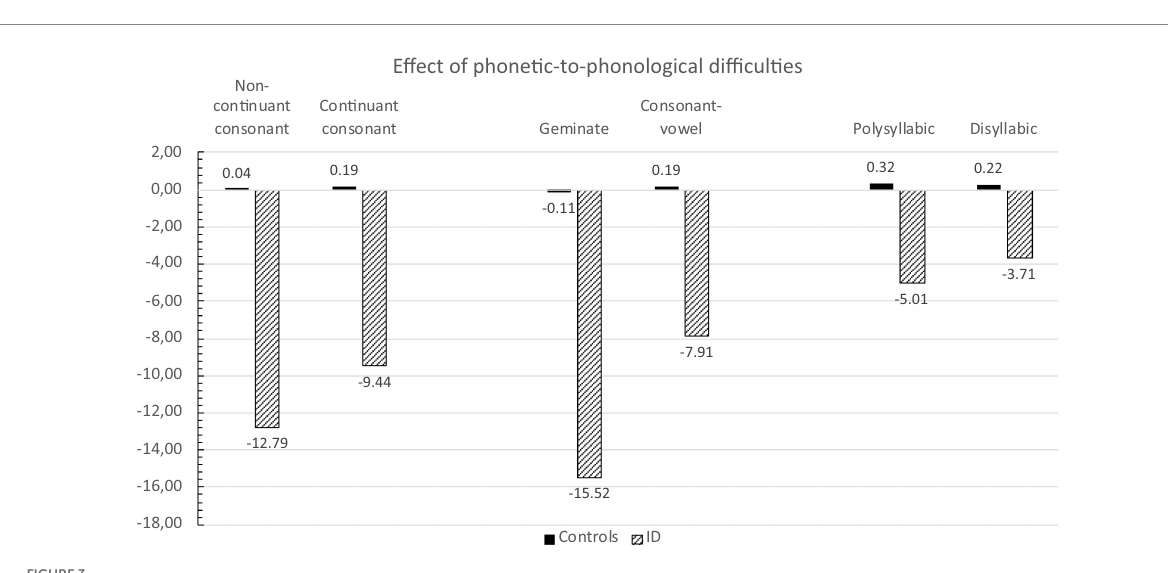
FIGURE 3 Mean accuracy z scores for the different subsets of Words and Nonwords Dictation Test by control and ID